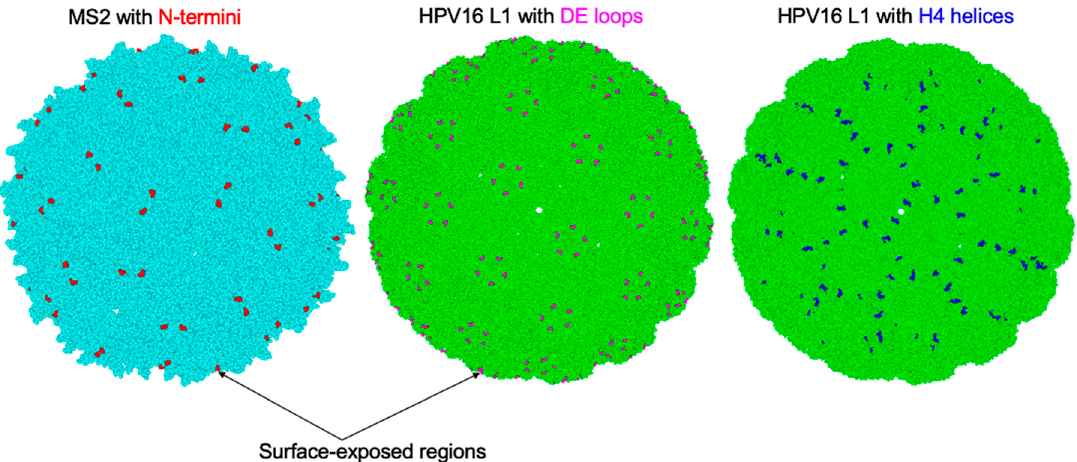
Figure 4. Model cryo-electron microscopy images of icosahedral structures of MS2 (light blue) and HPV16 L1 (light green) derived from protein data bank (PDB) with PDB identification numbers 2WBH and 5KEP, respectively. The N-termini on MS2 coat proteins where L2 peptides have been inserted are shown in red (left image). The DE loops on HPV16 L1 coat proteins where L2 peptides have been inserted are shown in magenta (middle image). The H4 helices on HPV16 L1 coat proteins where L2 peptides have been inserted are shown in blue (right image).